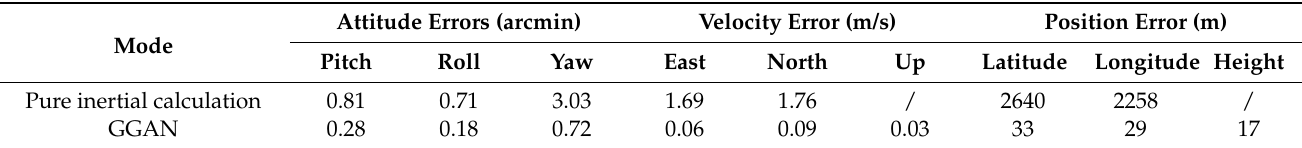
Table 2. Comparison of long voyage performance.